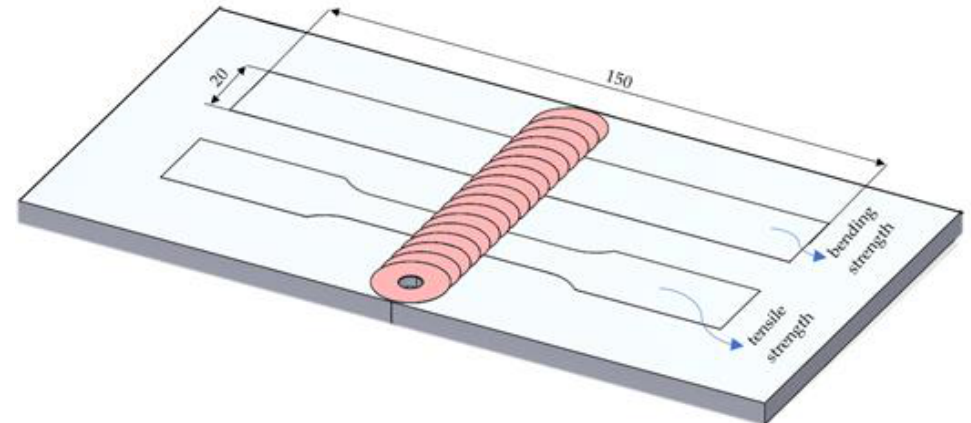
Figure 1. An example of the prepared specimens.